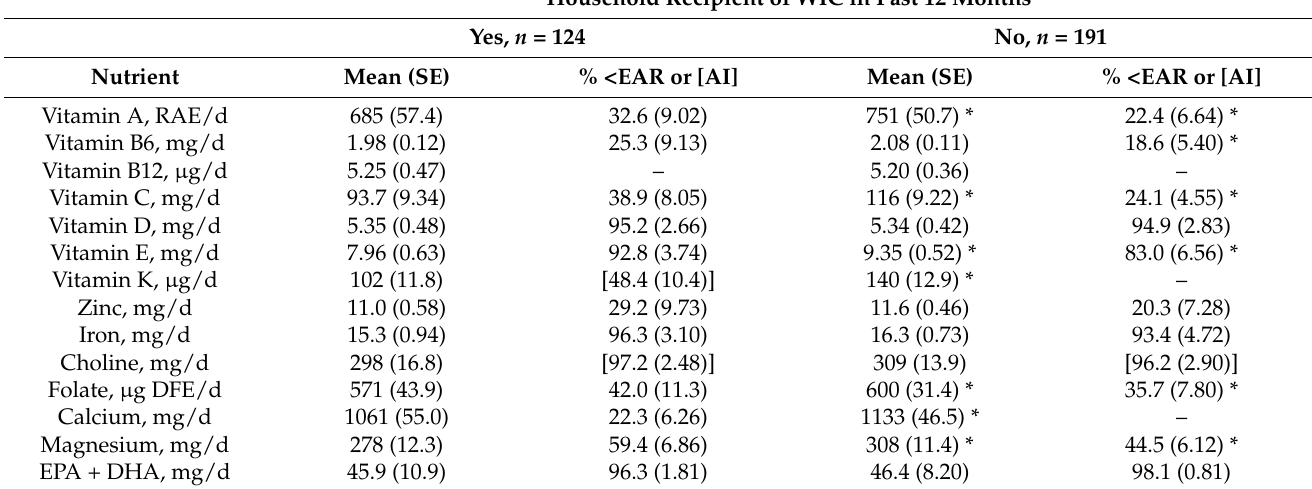
Table 5. Total usual intakes of nutrients important for neurodevelopment (foods alone) among pregnant non-lactating US women aged 20–44 y in the NHANES Survey by WIC participation.